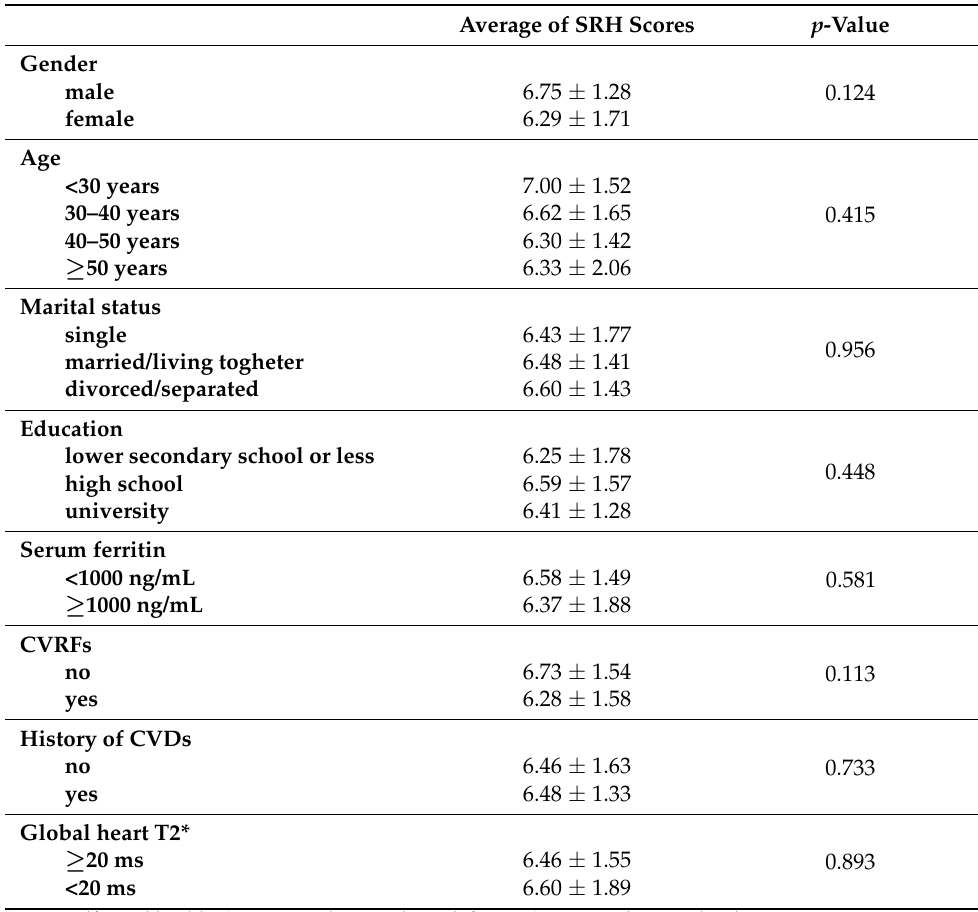
Table 4. SRH status of the subgroups with different demographic and health status. Average of SRH Scores p